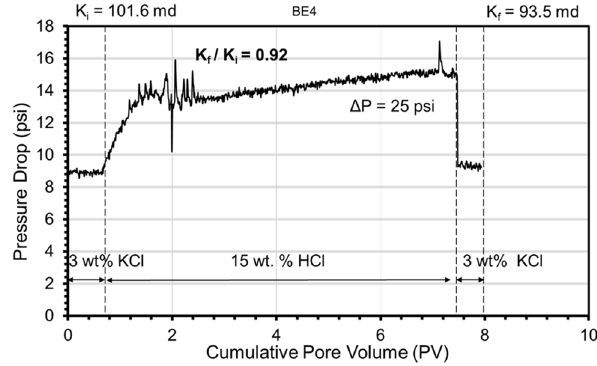
Fig. 2 Pressure drop across the sample Bandera Grey sand- stone (BR2) as the 15 wt% HCl injected at 5 cm 3 /min (backpres- sure = 1000 psi, confining pressure = 1700 psi)